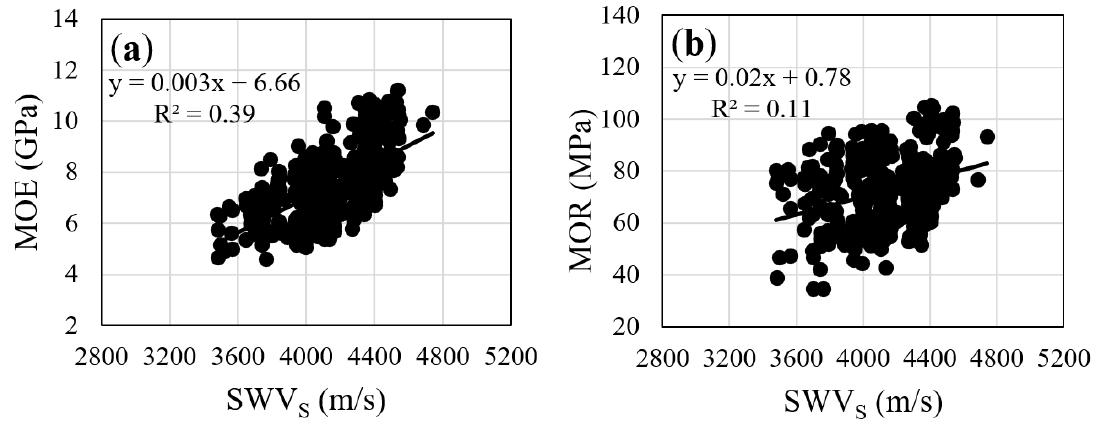
Figure 4. Relationship between stress wave velocity of specimens (SWV S ) and static properties: ( a ) modulus of elasticity (MOE) and ( b ) modulus of rupture (MOR) for all clones.